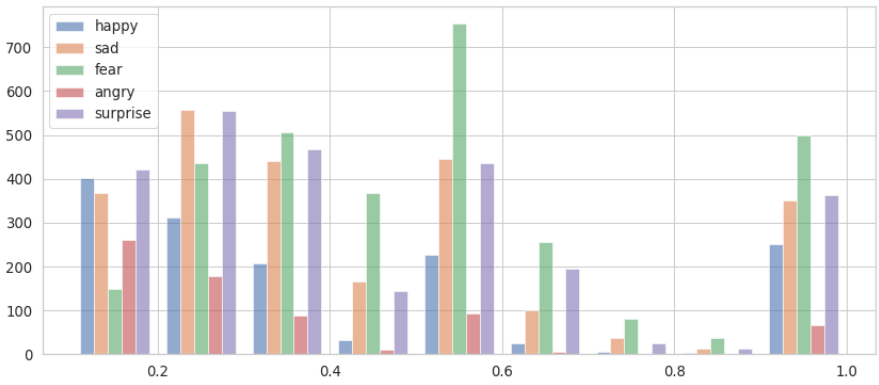
Figure 7. Histogram of BitChute emotion detection on